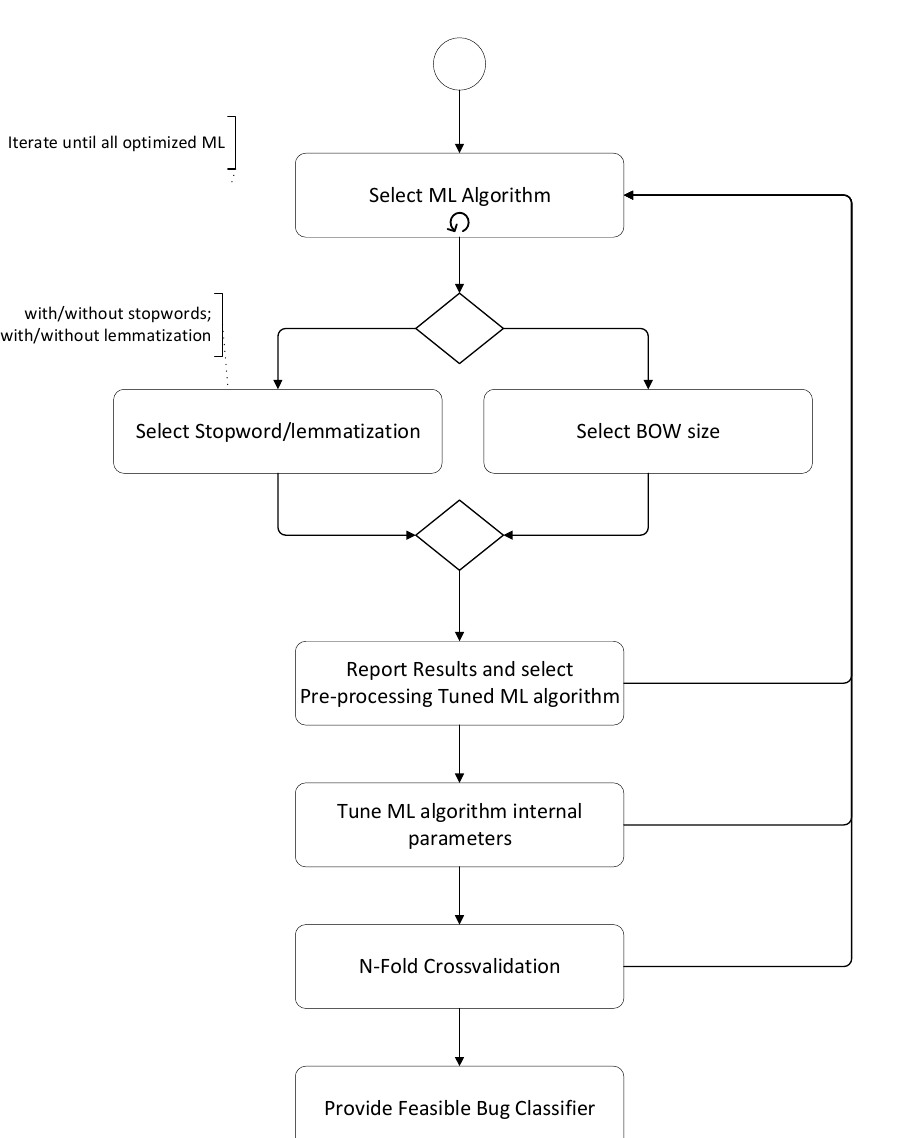
Figure 5. Adopted machine learning training approach for the case study